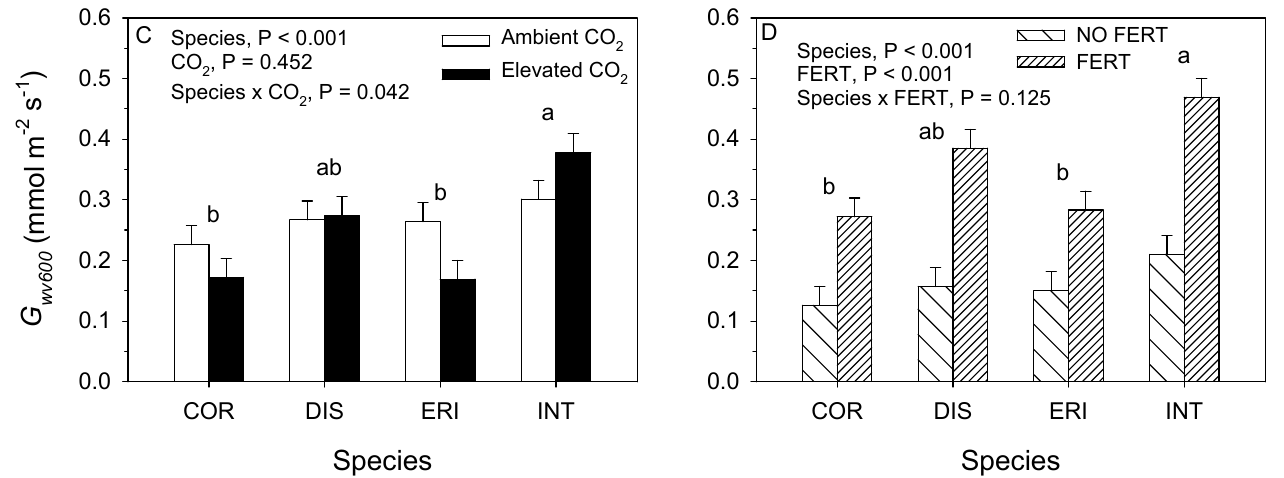
Figure 3. ( A ) Stomatal conductance at 600 ppm (G wv600 ) (mean ± SE) by willow species and CO 2 treatments, 2017, ( B ) by willow species and moisture stress treatments, 2017, ( C ) by willow species and CO 2 treatments, 2018, and ( D ) by willow species and fertilization treatments, 2018. If lower case letters differ among willow species than significantly different using Tukey’s mean separation test ( p = 0.05).